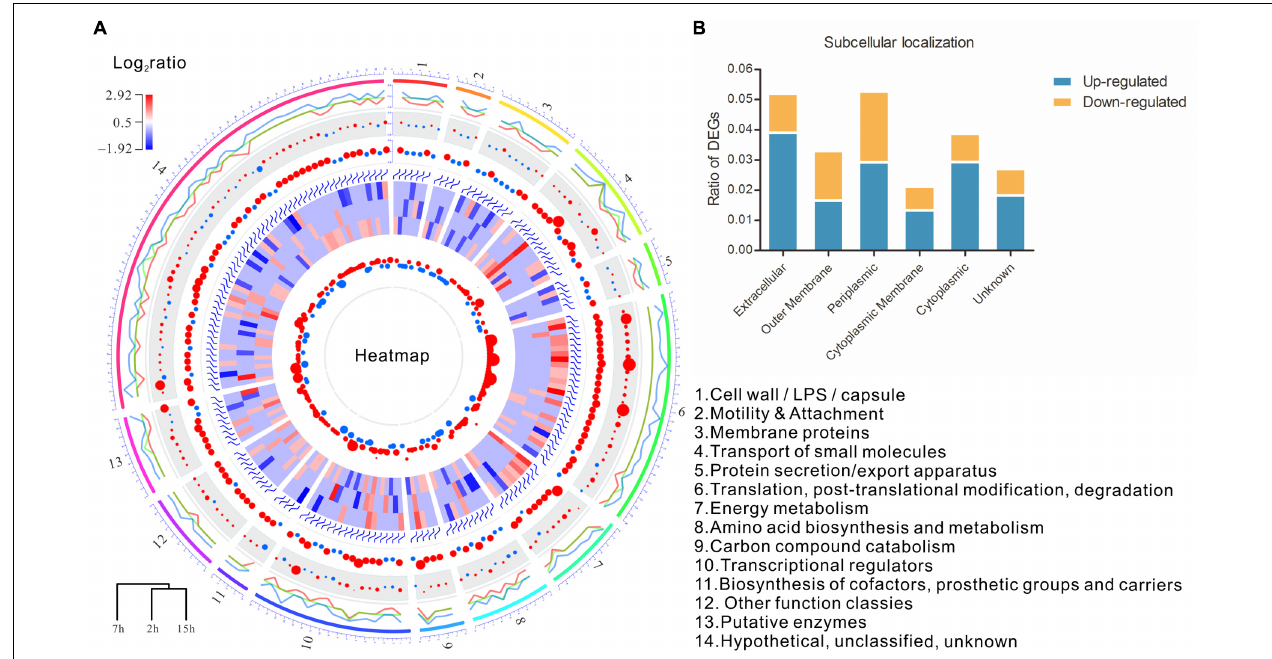
FIGURE 3 | Microarray analysis reveals influence of gp70.1 on gene expression of PA3. (A) Circular plots generated by OmicCircos showing the expression and function of DEGs. A total of 178 DEGs and 14 terms (1–14) of PseudoCAP function were involved. Circular tracks from outside to inside: track 1 shows the 14 PseudoCAP functions showed with different colors numbered with 1 to 14; track 2 is the three lines for quantile values for the detected fold changes (log 2 ratio) of gene expression ranged from − 1.9 to 2.9. The middle line is for the median, the outside line and the inside line are for 90 and the 10%, respectively; Track 3 is the circle points with the center = median and radium = variance; Track 4 is the circle plot with the center equal to the mean and scaled value; Tracks 5 is the heatmap of 178 DEGs (red: up-regulated, blue: down-regulated); Track 6 is the circle plot with the center = median and radius = standard deviation; Track 7 is the 95% confidence interval of the fold changes. (B) Subcellular localization of DEGs. The percentages of up- or down-regulated genes in each subcellular localization were calculated and shown on y -axis.